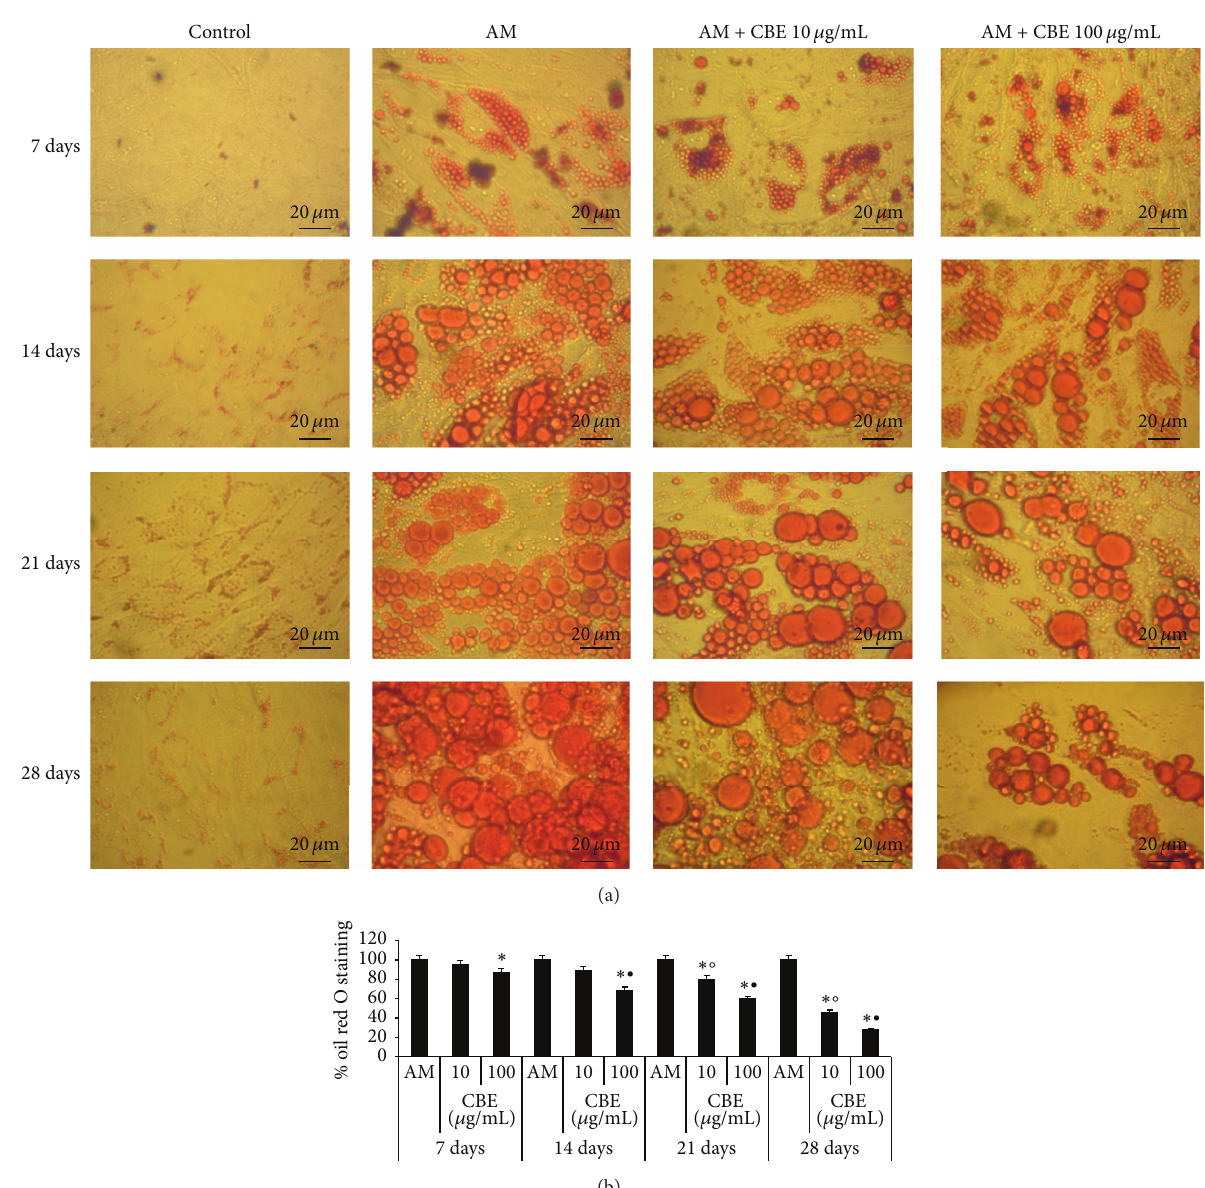
Figure 2: Effect of 10 and 100 𝜇 g/mL Citrus bergamia extract (CBE) on the lipid content of mesenchymal stem cells stained with oil red O duringadipogenicdifferentiation.Cellswereexaminedat7,14,21,and28daysfromthestartofdifferentiation.(a)Arepresentativephotograph from three independent experiments of untreated control (Control), adipogenic medium-treated cells (AM), and AM plus 10 or 100 𝜇 g/mL CBE was shown. (b) The levels of oil red O incorporation were quantified by measuring the absorbance of isopropyl alcohol extract at 𝜆 = 550 nm. Data were shown relative to AM and expressed as mean ± SD from three independent experiments. ∗ 𝑝 < 0.01 versus AM (100%) at same day; ∘ 𝑝 < 0.05 versus CBE 10 𝜇 g/mL at 7 days; ∙ 𝑝 < 0.01 versus CBE 100 𝜇 g/mL at 7